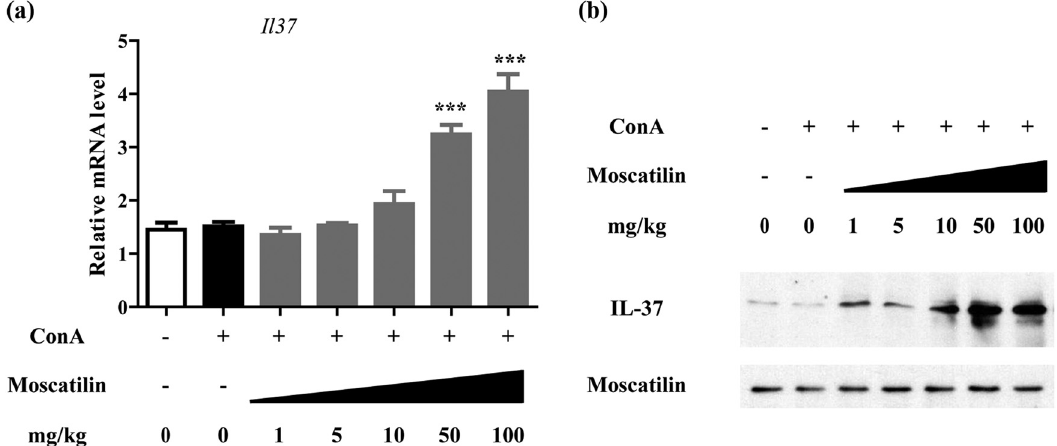
Figure 4: Moscatilin induced IL - 37 expression in the hepatic tissues. ( a ) The mRNA expression of IL37 genes in the liver tissues was detected 24 h after the ConA injection by real - time RT - PCR. Each group contained 5 tissue samples and *** indicated p value less than 0.001 compared to the ConA group. ( b ) The protein level of IL - 37 in the liver tissues was detected 24 h after the ConA injection by western blot. GAPDH was used as the loading